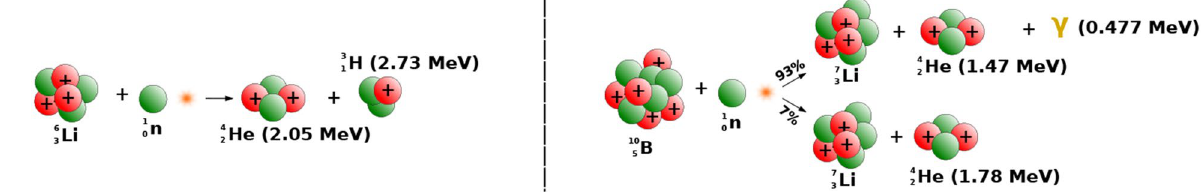
Figure 1. Thermal neutron capture reaction scheme of the 6 3 Li and 10 5